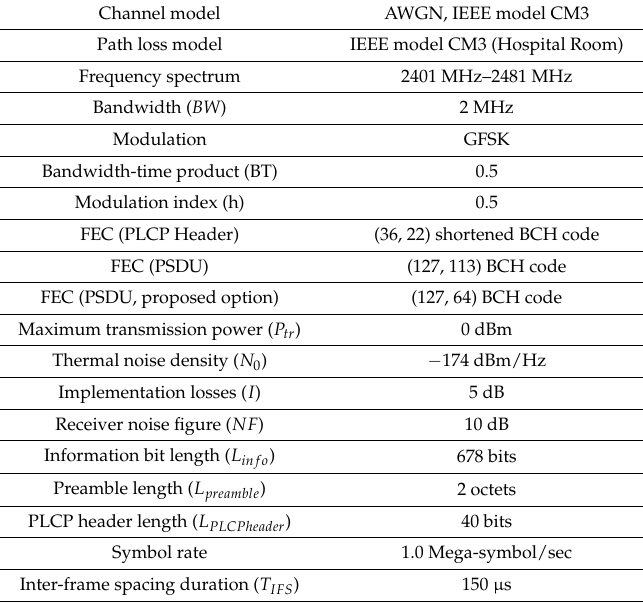
Table 2. Computer simulation parameters.